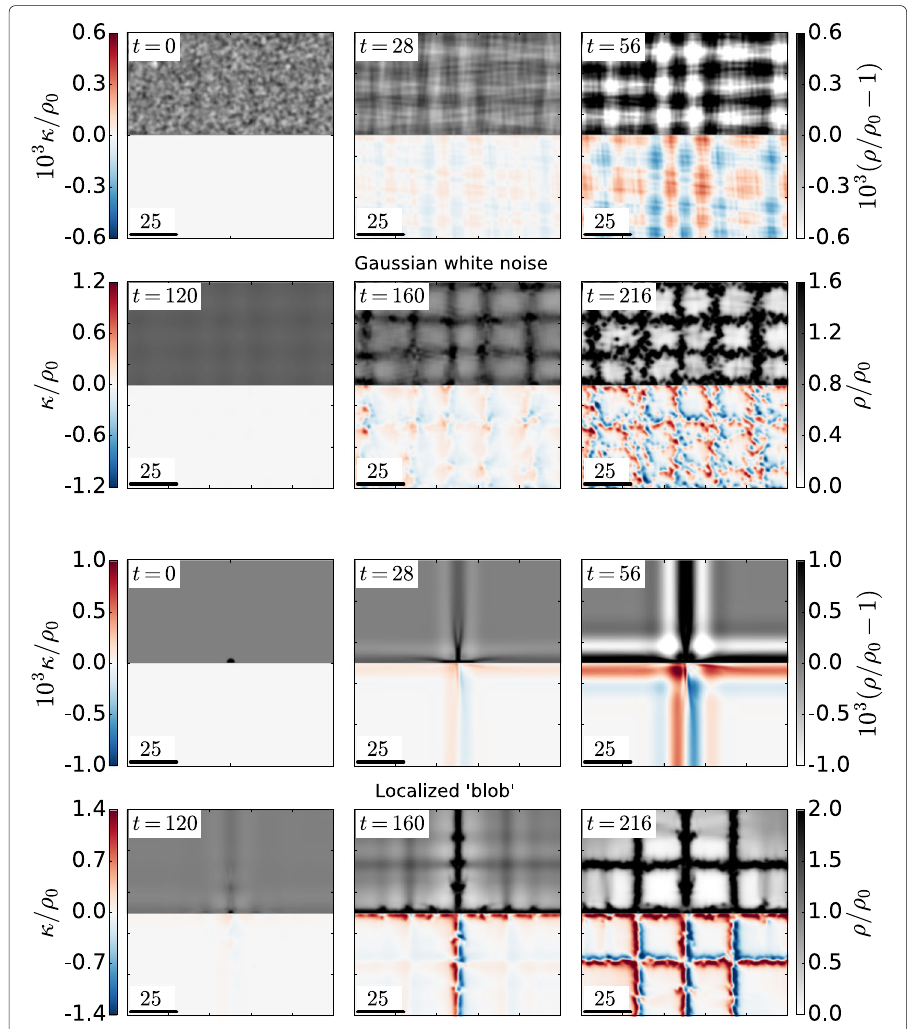
Fig. 3 Time evolution of spatial patterns ρ( r , t ) and κ( r , t ) ; top: patterns growing from uncorrelated Gaussian noise (initial condition (i)), bottom: patterns growing from a single localized perturbation (initial condition (ii)); parameters: D = A = 0.2, τ ext = 1.1, these parameters are chosen to match experimental observations shown in Fig.